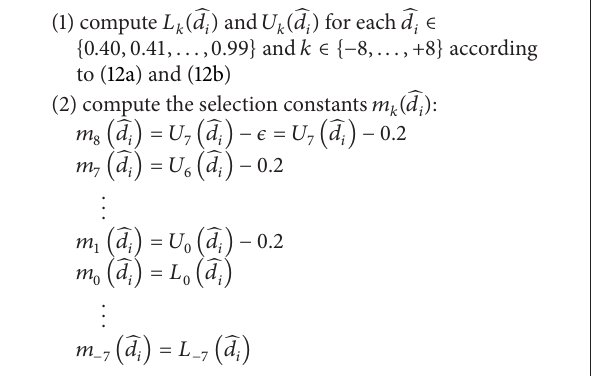
Algorithm 4: Algorithm for the calculation of the type3 selection constants.